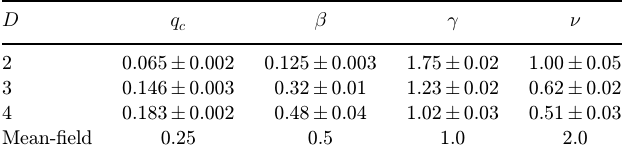
Table 1. Critical points q c and the critical exponents (cid:2) , (cid:3) and (cid:4) for distinct lattice dimensions. The mean-¯eld values were obtained from Ref.